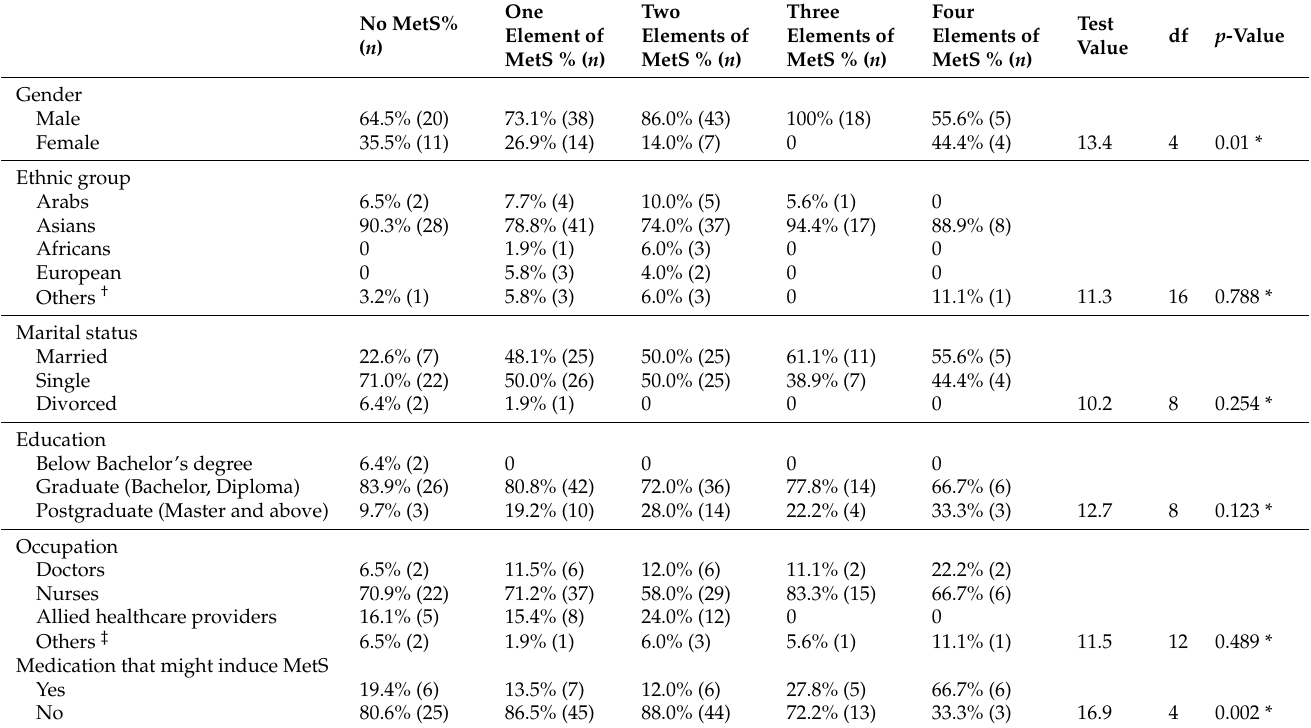
Table 6. Comparison of migrants with one, two, three and four elements of MetS and MetS-free migrants 24 months post-migration to Qatar regarding variables of demographics and the